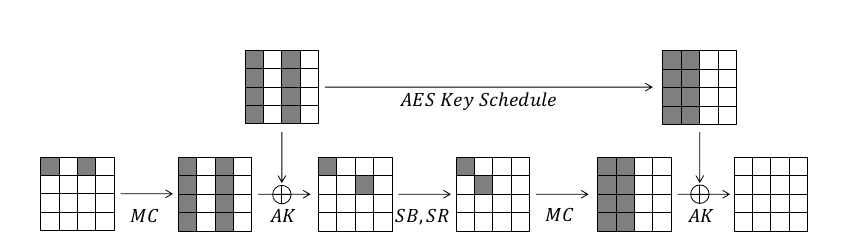
Figure 2: An example of linear incompatibility for 2-round AES in [FJP13, Figure